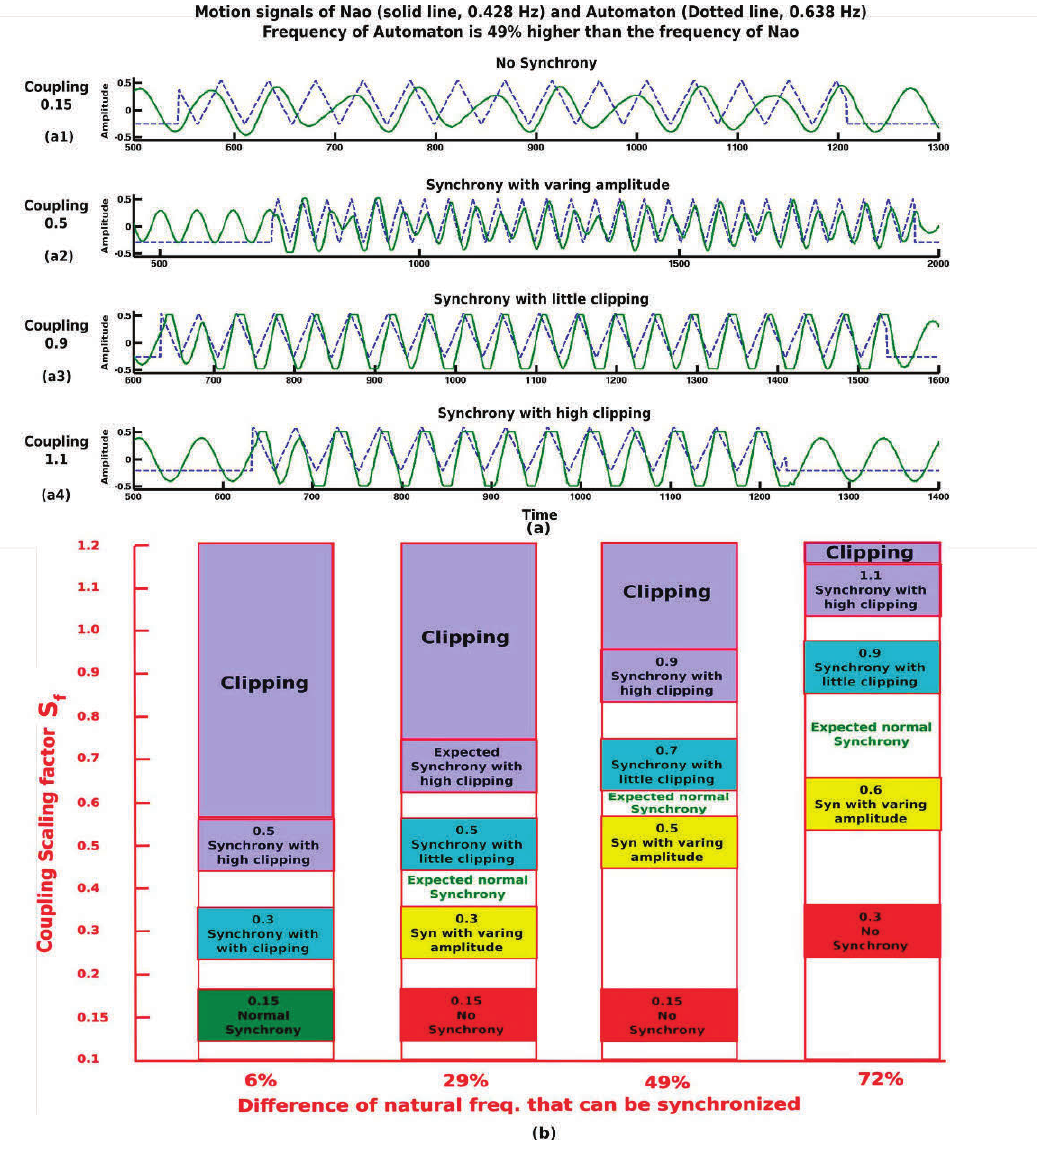
Figure 6. (a) and (b) demonstrate the fact that how the range of interacting frequencies ∆ f (di(cid:636)erence of interacting frequencies) can be expanded by scaling the coupling energy. (a) motion signals of Nao (solid line, 0 . 428 Hz) and Automaton (dotted line, 0 . 638 ), frequency of the automaton is 49% higher than the frequency of Nao. It details that how the coupling scaling factor influences the interaction. Similarly, (b) compares the e(cid:636)ect of increasing scaling factor (coupling) on 4 di(cid:636)erent ∆ f ( 6% , 29% , 49% and 72% ).